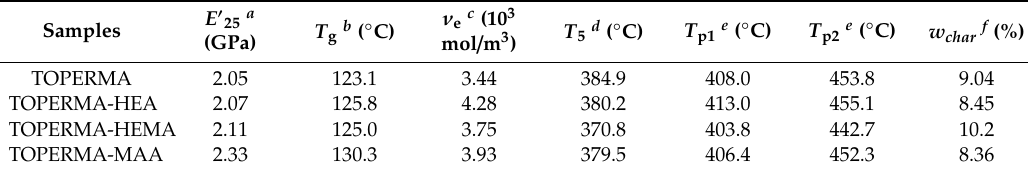
Table 2. Dynamic mechanic and thermal properties of the cured TO-based resins.